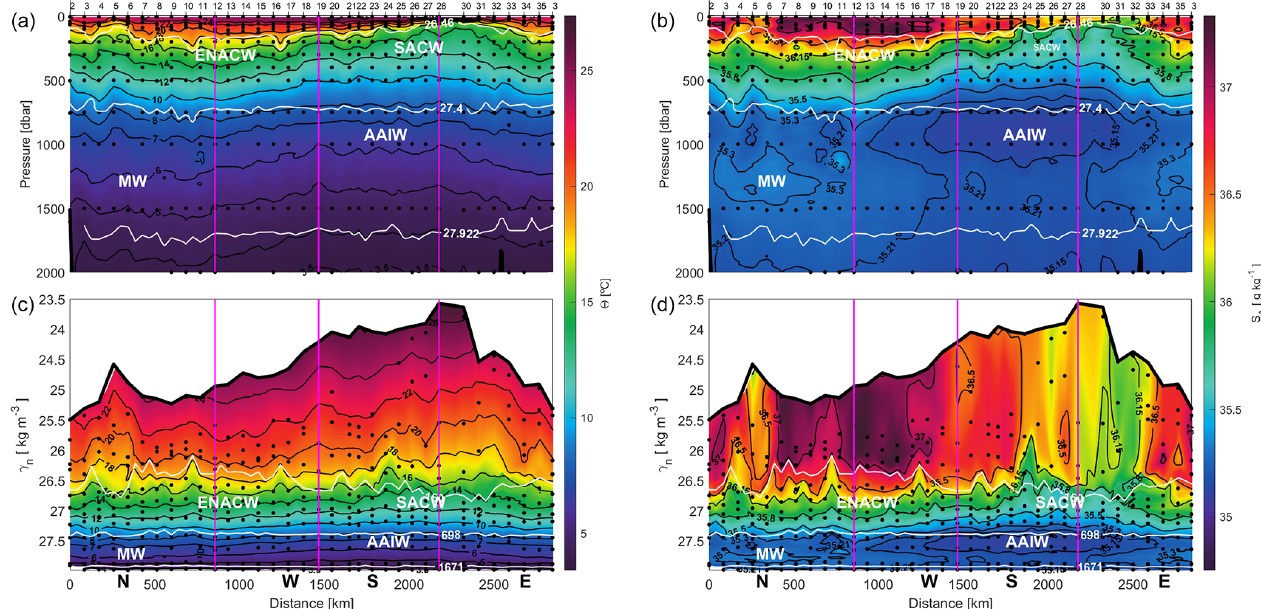
Figure 5. Sections of (cid:50) (a, c) and S A (b, d) with respect to depth (upper line) and γ n (lower line) during the FLUXES-I cruise. The direction chosen for the representation is the same as in Fig. 3. The northwestern, southwestern and southeastern corners are indicated by three vertical pink lines at stations 12, 19 and 28, respectively. In depth sections, the isoneutrals that delimit the surface, central, intermediate and deep water are represented by white contours. In γ n sections, the depths of 150, 698 and 1671m are also shown. The sampling points for dissolved oxygen and inorganic nutrients used in this work are represented by black dots. Sections are only estimated with the CTD–XBT merged